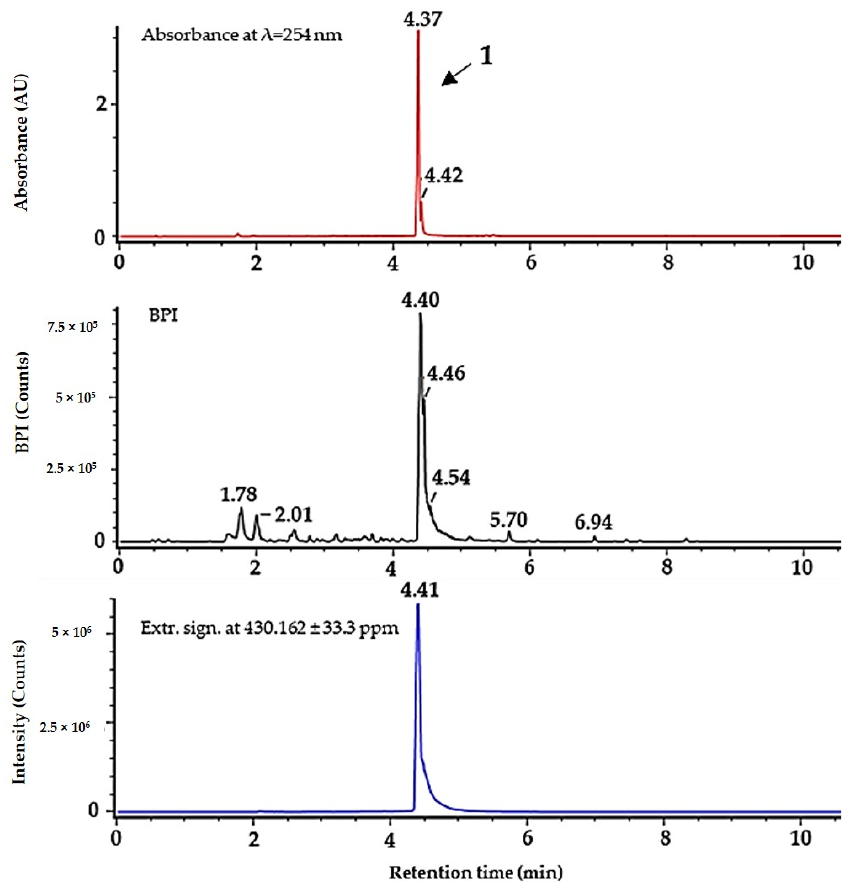
Figure 2. Purity of serratiochelin A ( 1 ) after isolation using FLASH chromatography, analyzed by UHPLC-MS. Top (in red) absorbance at 254 nm, middle (black) BPI chromatogram, bottom (blue) extracted signal for m / z = 430.162 ( ± 33.3 ppm). ∆ RT for UV / Vis detector is ~ − 0.05 min.